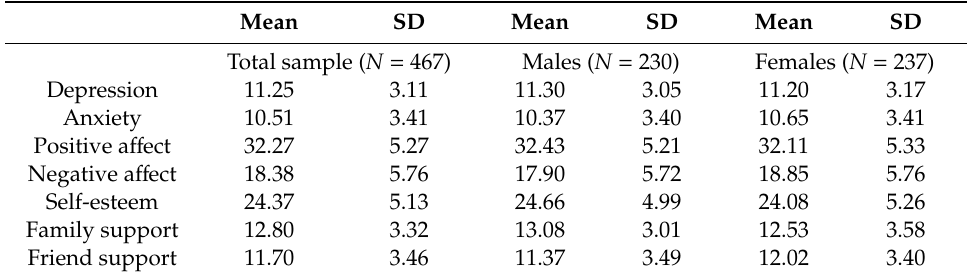
Table 1. Descriptive statistics for the total sample and male and female groups collected from the initial